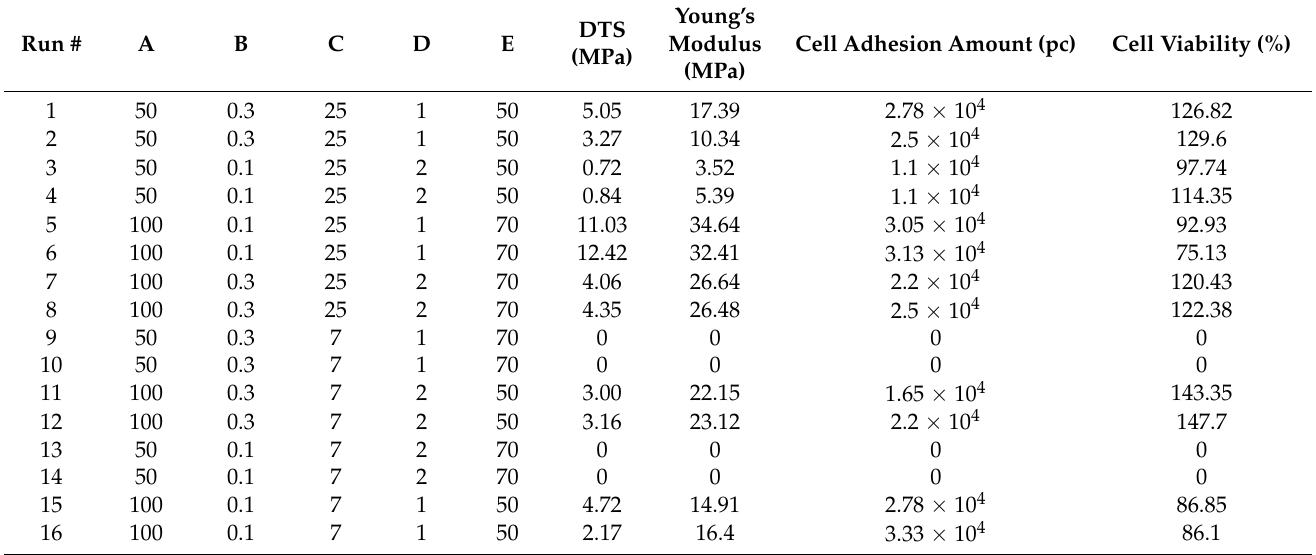
Table 3. Experimental factors (columns 2–6) and response variables (columns 7–10) of the 2 5 − 2 fractional factorial screening design